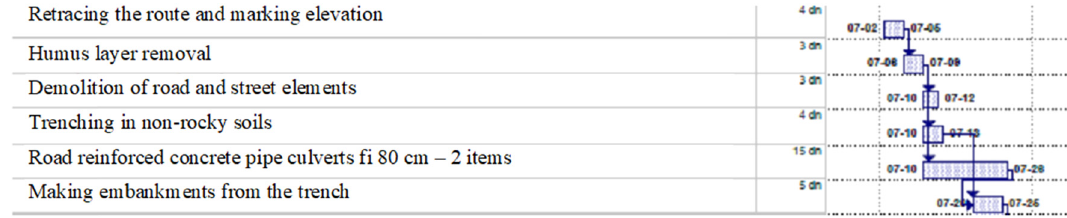
Figure 5: The risk value for the i - th surveying task considering all